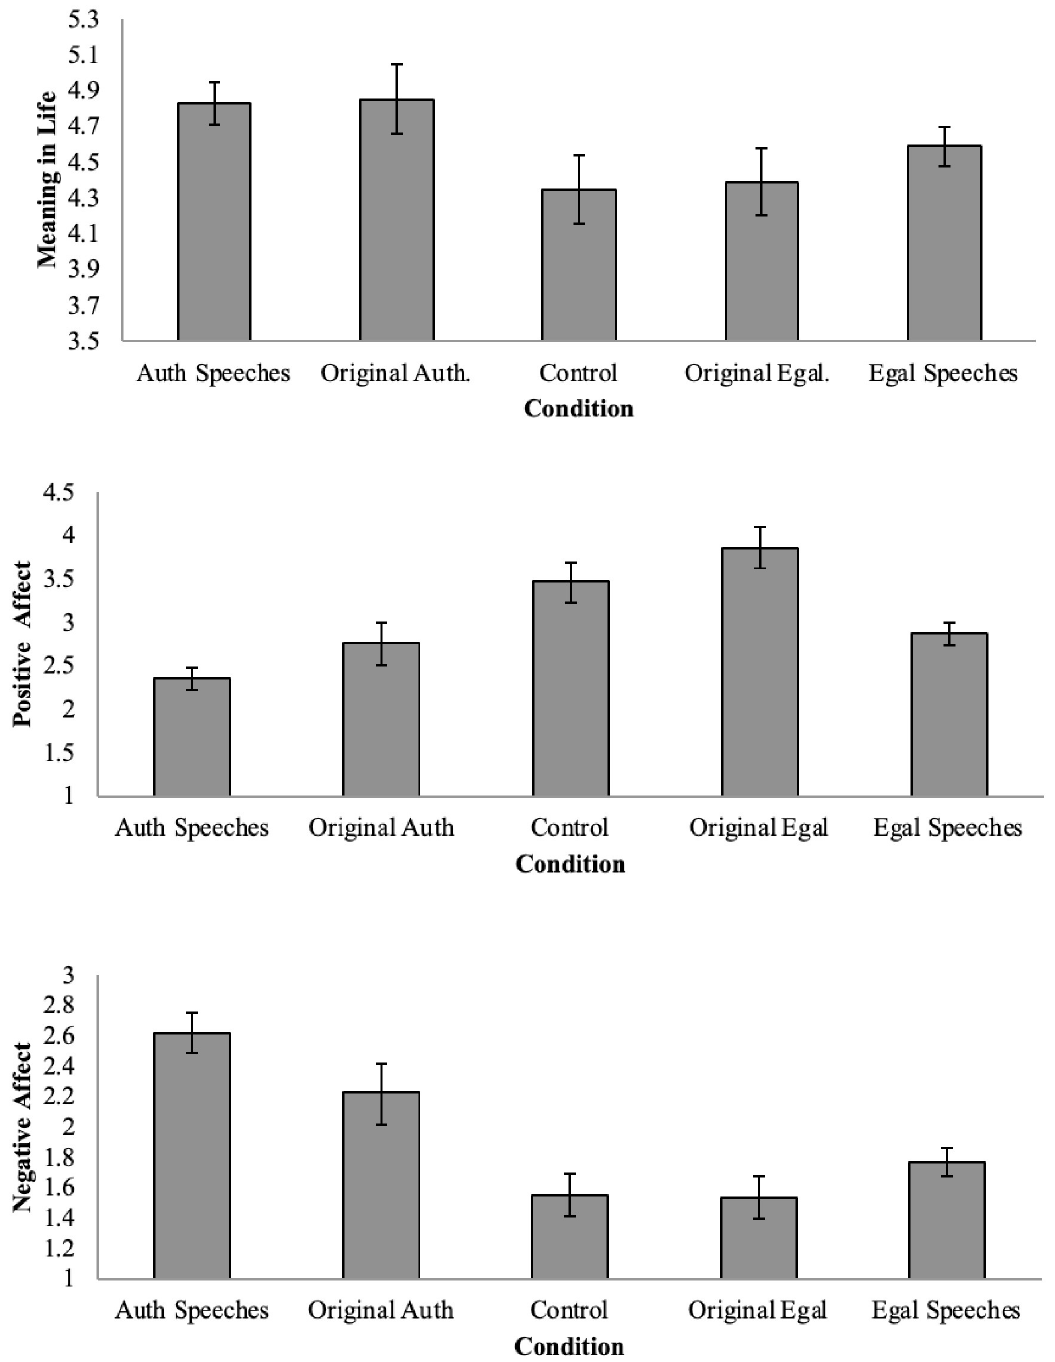
Fig 1. Effects of condition on meaning in life (top panel), positive affect (middle panel), and negative affect (bottom panel) Study 2. Note . Auth = Authoritarian; Egal = Egalitarian. Error bars are 95% Confidence